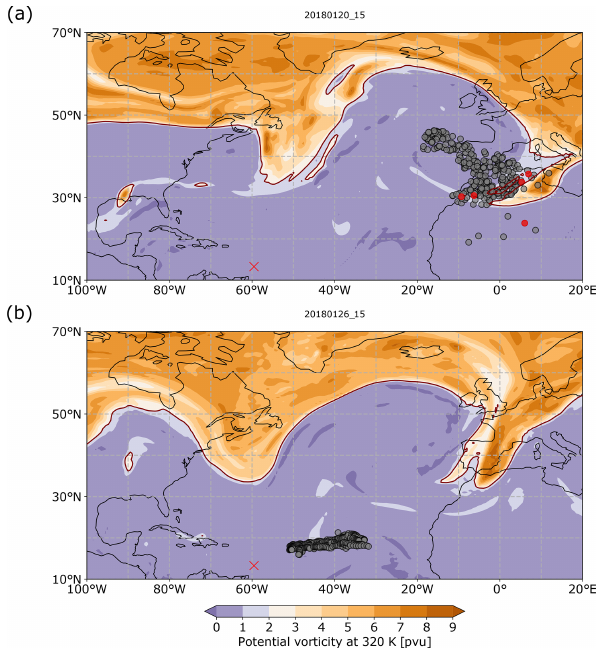
Figure 12. Upper-level PV at 320K at 15:00UTC on 20 Jan- uary 2018 (a) and 26 January 2018 (b) . During this period, air parcels that reach Barbados between 28–30 January descend above Portugal, Spain and North Africa (position of air parcels shown by dots). The air parcels that experience rapid descent ( > 300hPa(2d) − 1 ) centred at the time shown in the figure are high- lighted in red (five air parcels in a ). The red cross indicates the po- sition of Barbados. An animation illustrating the 3-hourly evolution of the large-scale flow fields in the period 20 to 30 January 2018 is provided as Supplement